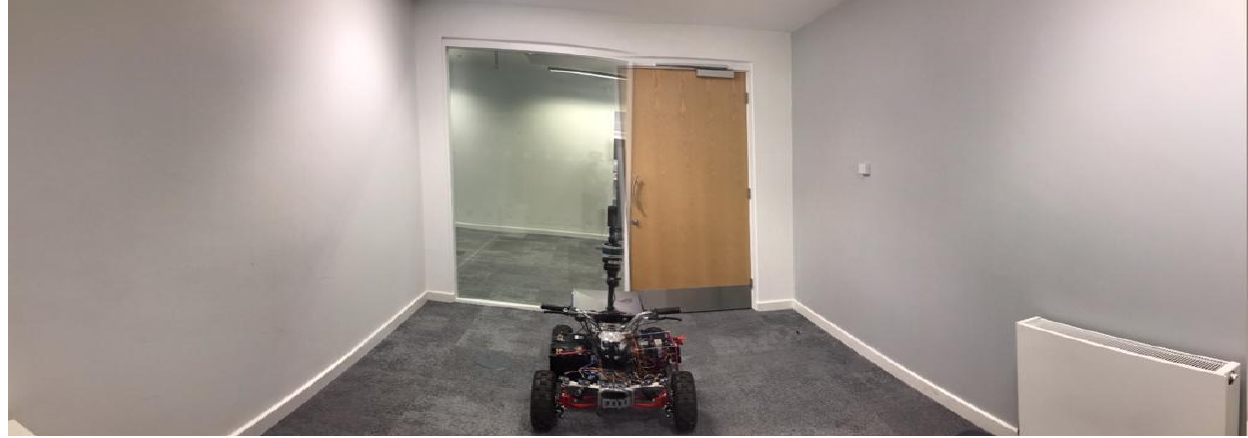
Figure 11. Experiment 2 room.